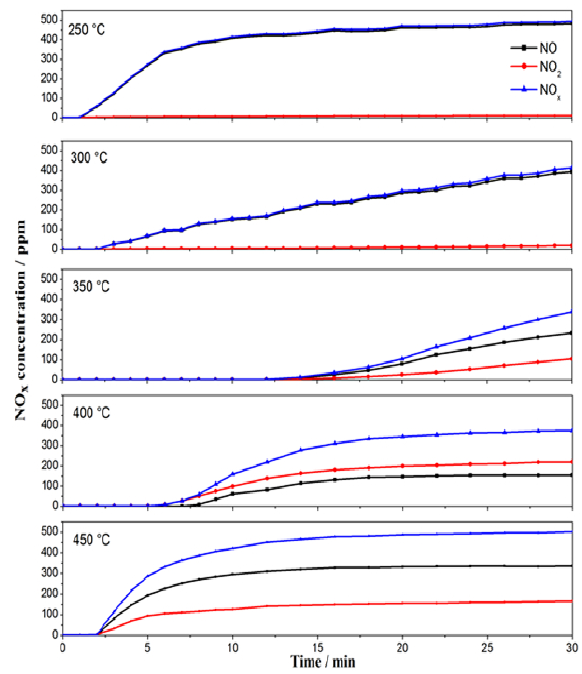
and NO (NO+NO ) breakthrough profile for 30 Figure 4: NO, NO 2 X 2 min at different temperature with lean feed consisting of 500 ppm NO+10% O +balance N , 60,000 h -1 . 2 2